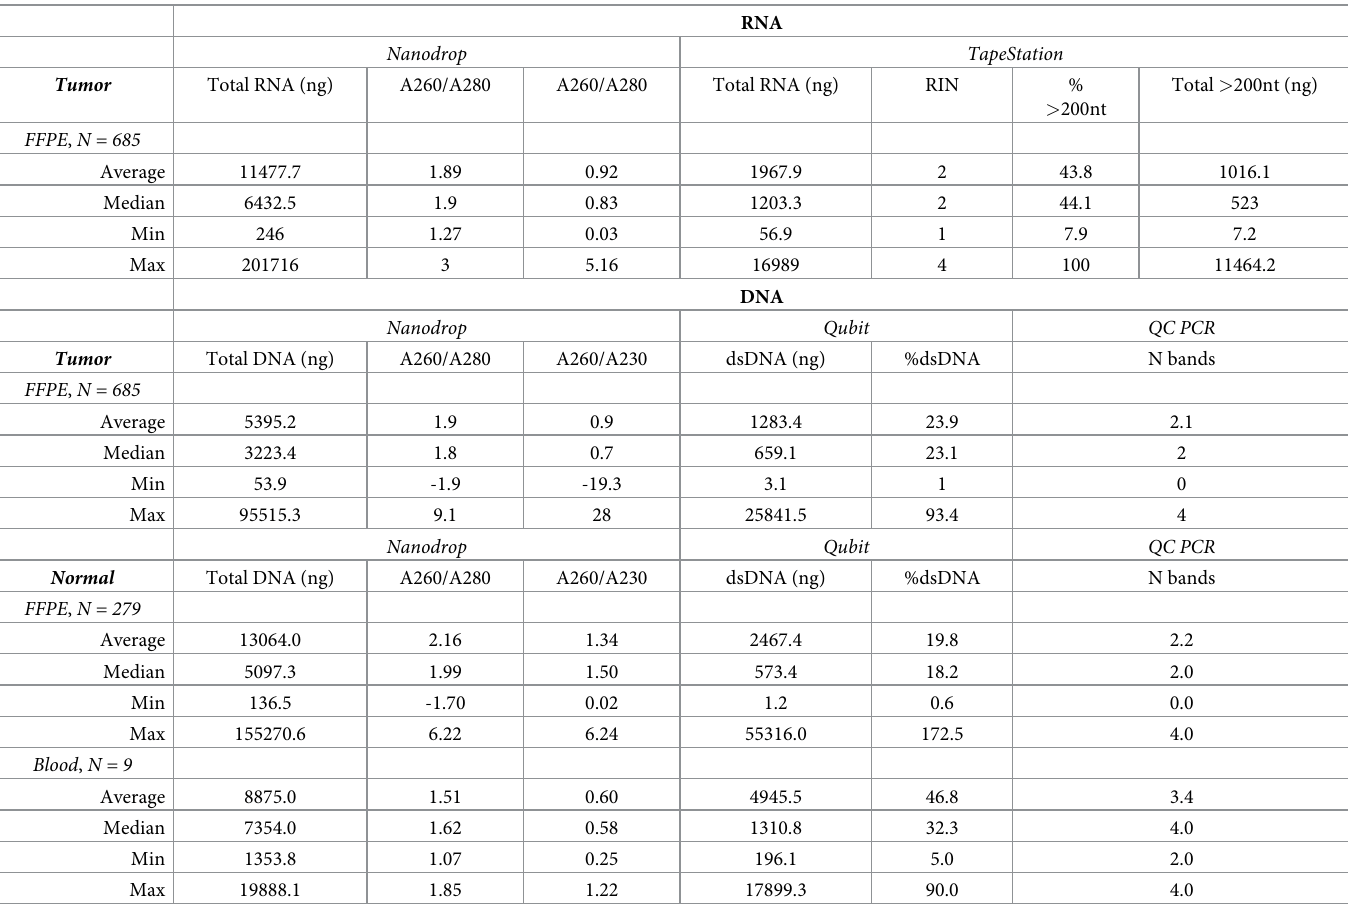
Table 3. Characteristics of RNA and DNA obtained from tumor and non-tumor tissues.